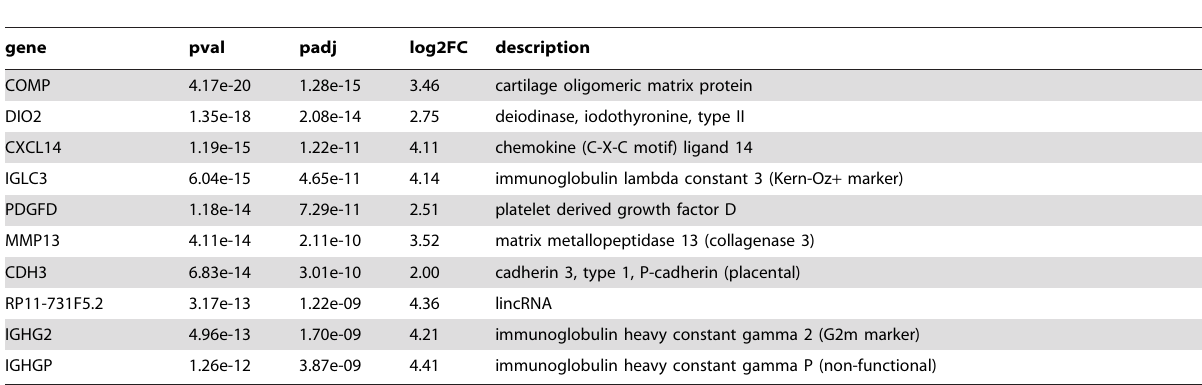
Table 1. Top ten differentially expressed genes (by